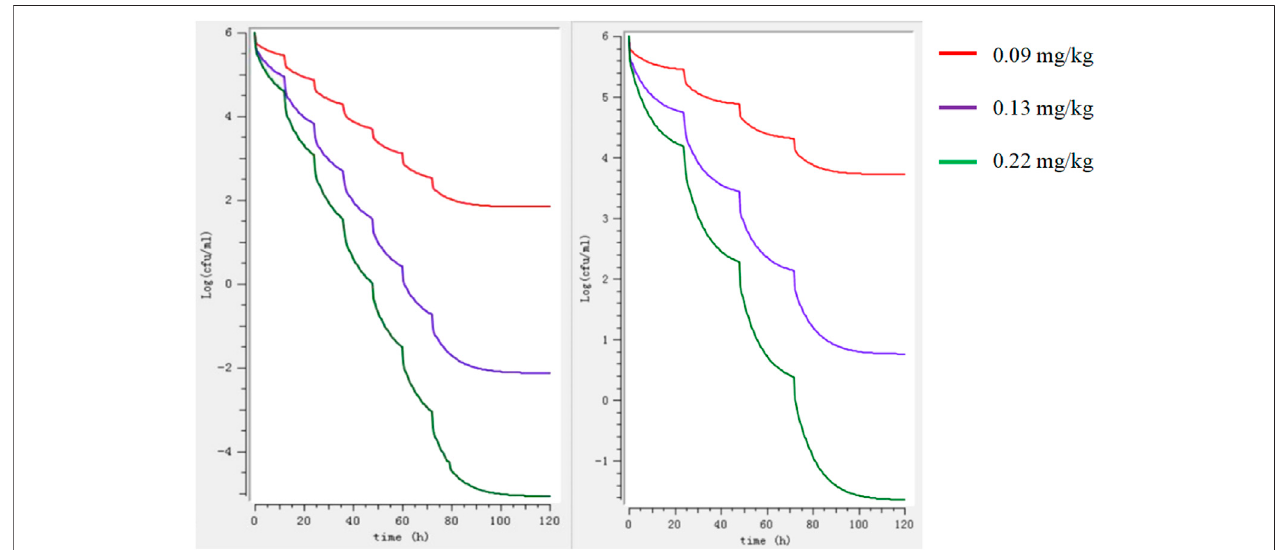
FIGURE 5 | Model predictions of the growth of Clostridium perfringens at different doses regimens. Note: The left image shows the 12-h interval, and the right image shows the 24-h interval.